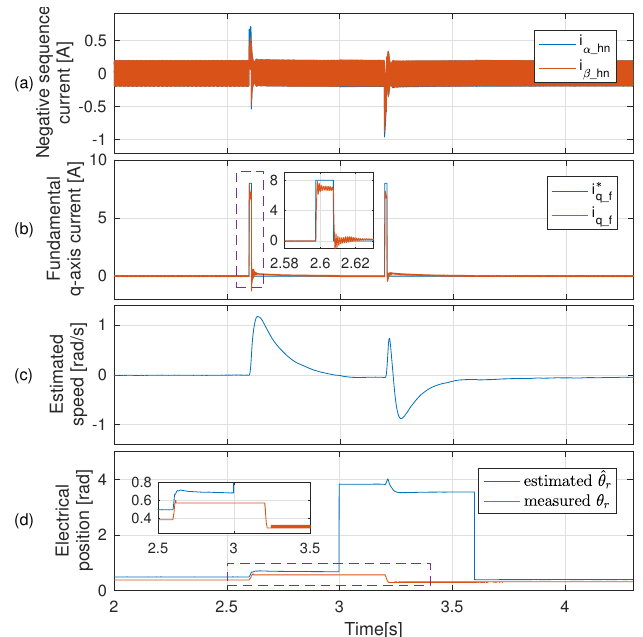
Figure 14. Initial rotor position estimation using the HFI method and conventional subtraction-based current filter with no